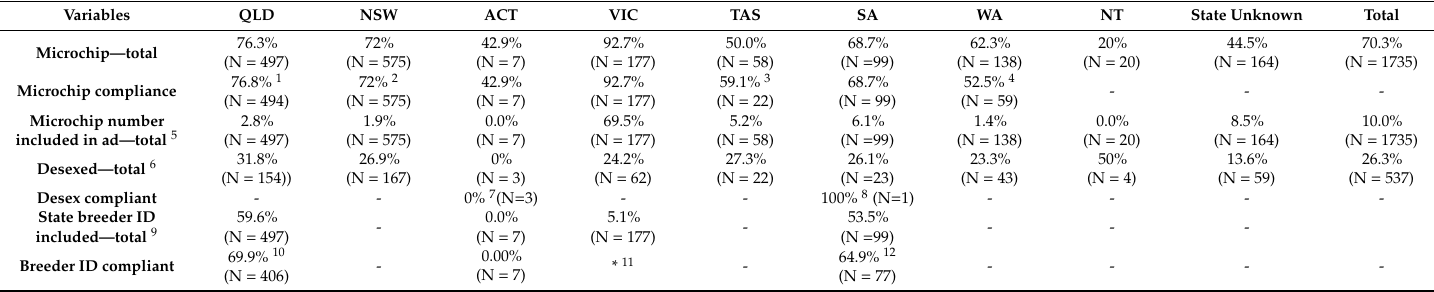
Table 7. Benchmark of total, and regulation compliance, in microchipping, desexing and breeder registration in Gumtree dog and puppy advertisements from two individual webscrapes (25 March and 8 April 2019) per state in Australia. Refer to Table 1 for regulations for each state and